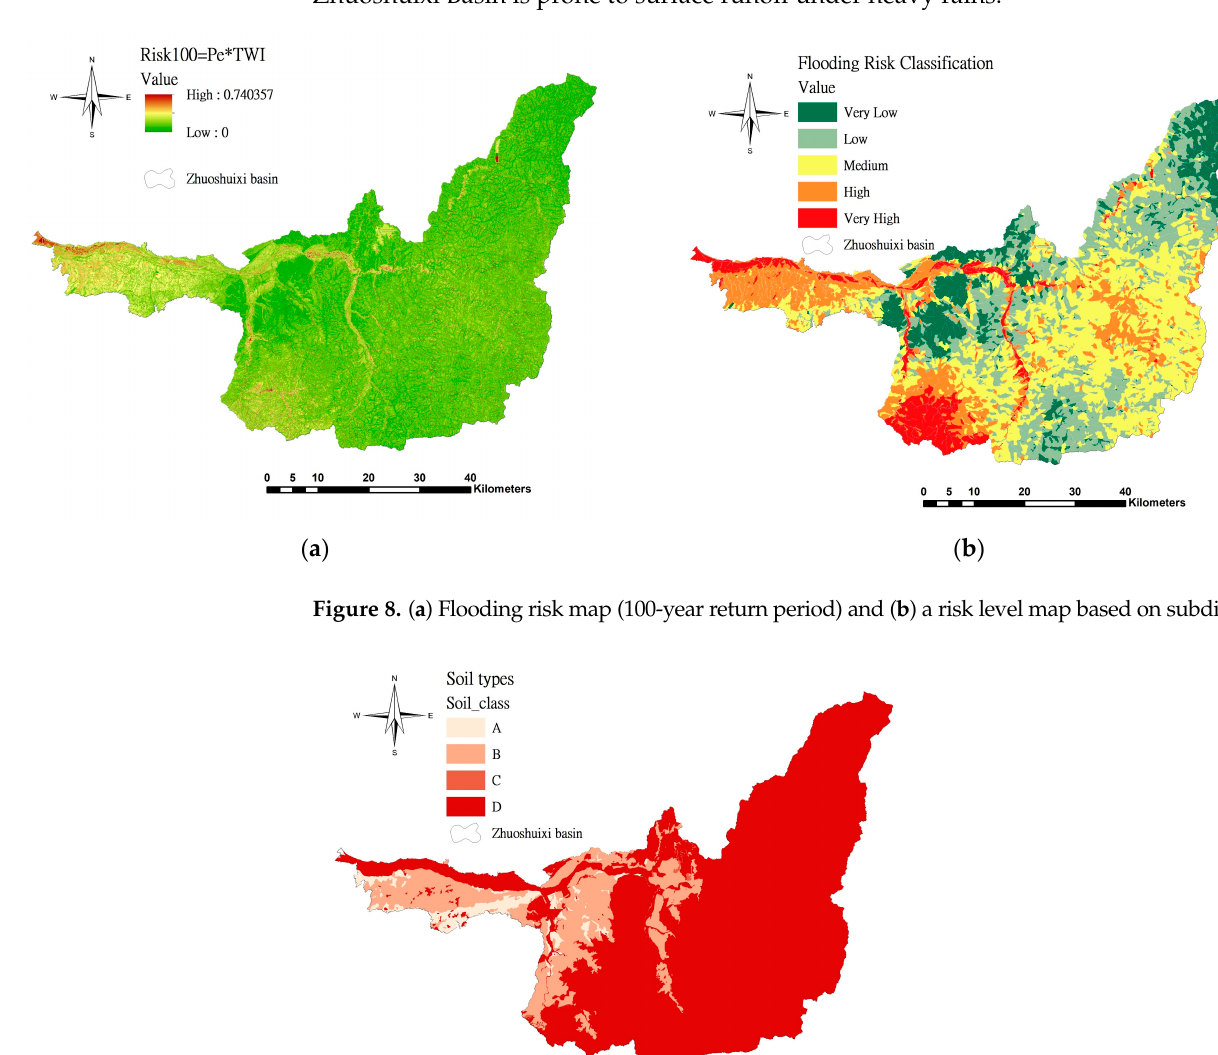
11 of 19 Figure 7. Correlation between estimated runoff and observed flow.